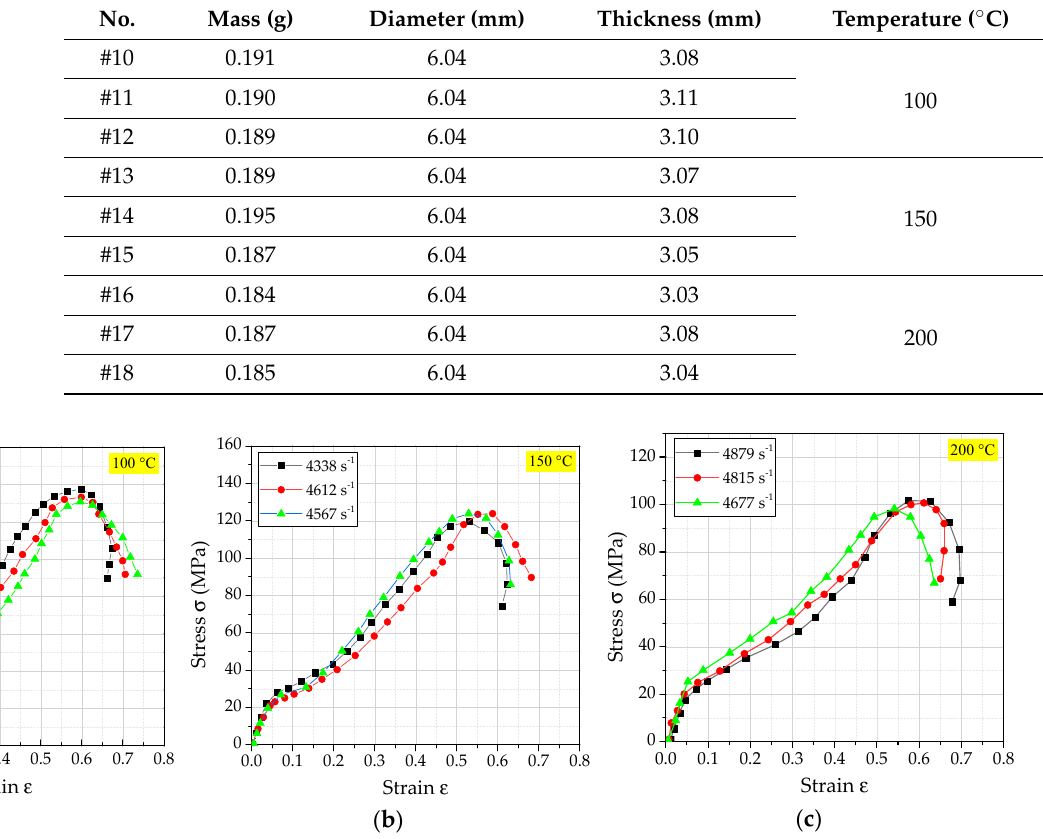
Table 5. The size parameters of samples at different temperatures.